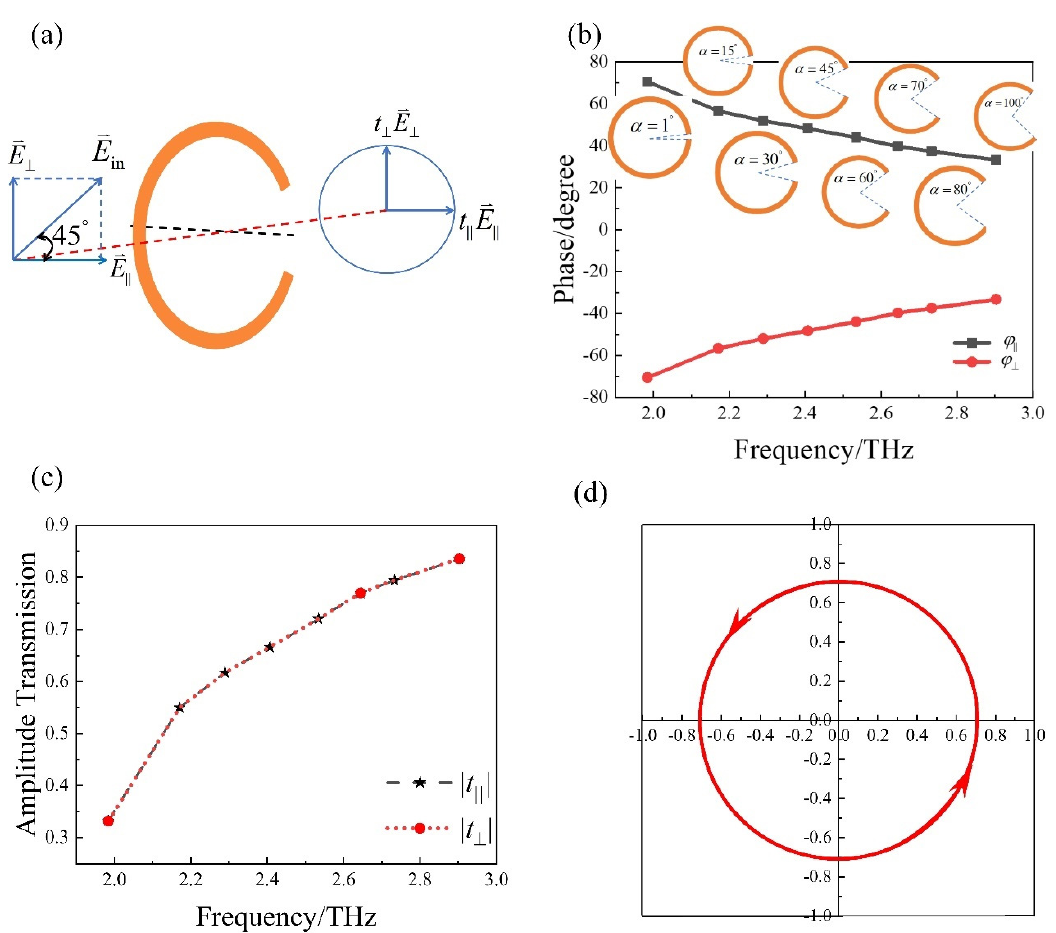
Figure 6. ( a ) Schematic of circular − shaped SRR to realize linear to circular polarization with rotation angle γ = 0 ◦ . Simulated transmission ( b ) phase and ( c ) amplitude for vertical and horizontal components with opening angle α varying from 1 ◦ to 100 ◦ . ( d ) Variation of electric field of scattered light in time domain at 2.49 THz, at z = − 10 µ